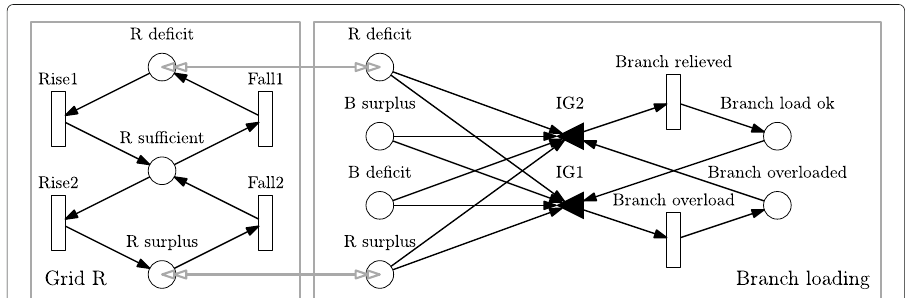
Fig. 5 SAN models of grid R and branch